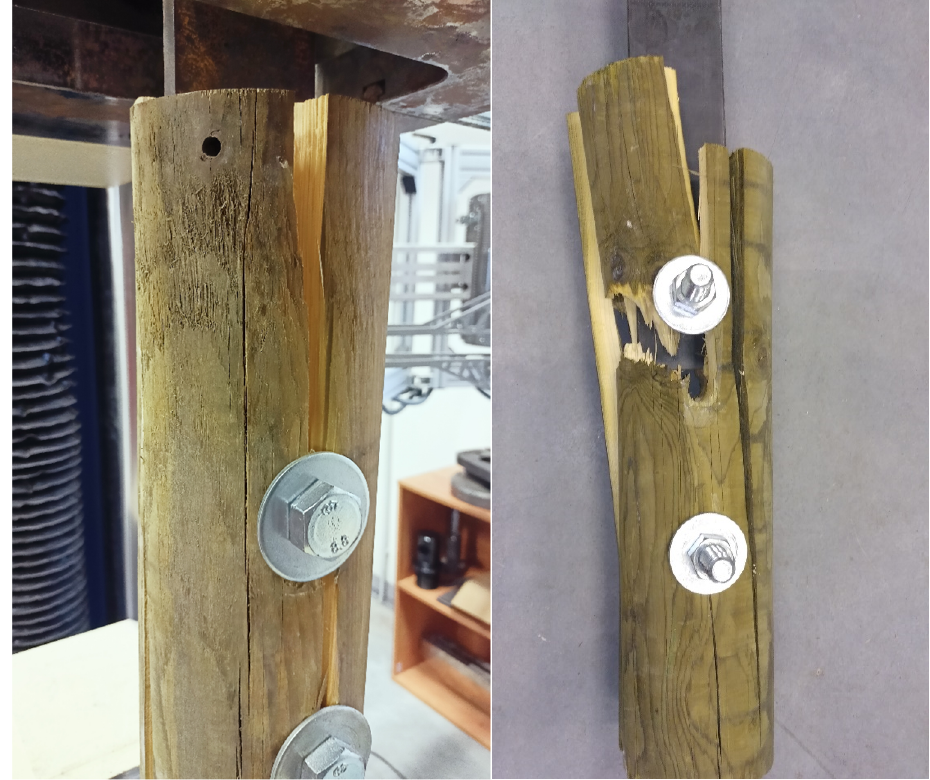
Figure 20. Specimens of round timber connections after failure.